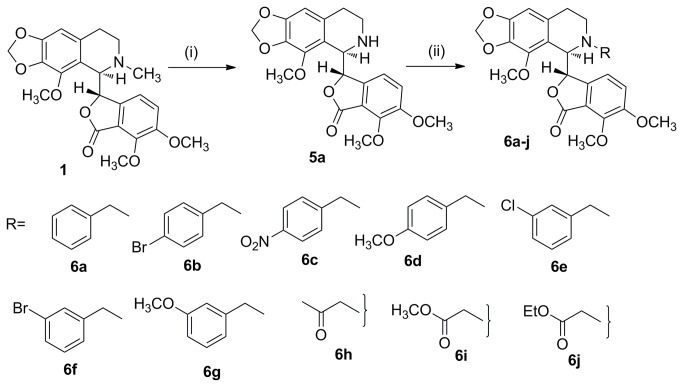
Synthesis of nornoscapine 5a and noscapinoids 6a-j from α-noscapine.Reaction conditions: (i) a: mCPBA, DCM; b: 2N HCl; c: FeSO4.7H2O; (ii) R-Br, KI, K2CO3, Acetone.